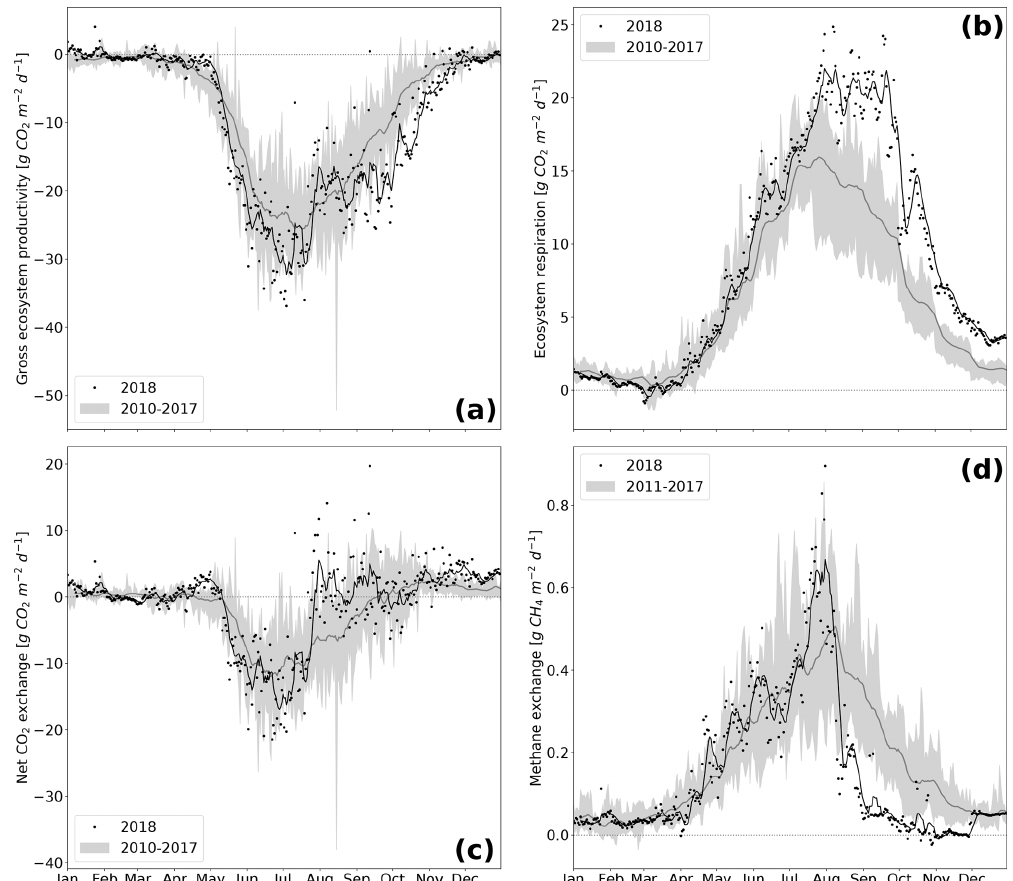
Figure 5. Component fluxes GEP (a) and R eco (b) of NEE (c) and CH 4 (d) over the course of the year. Variables are represented as the black line (7d rolling mean of black dots) for 2018 whereas the grey shading represents the variable range (minimum–maximum) throughout the reference period 2010–2017 (dark grey line is the mean of the reference